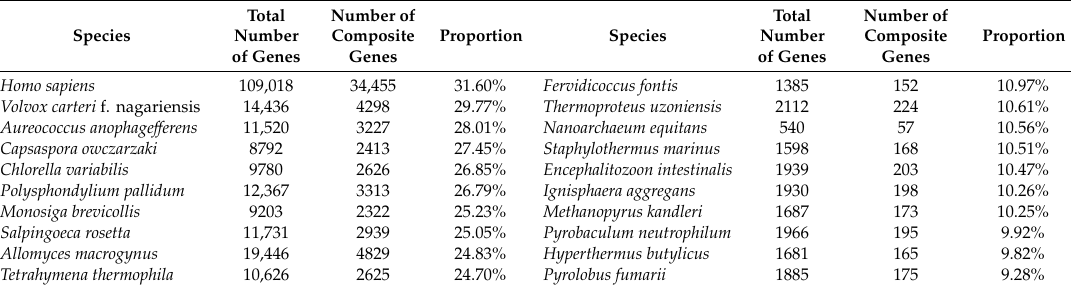
Table 1. The ten species that contain the highest (left) and lowest (right) proportions of composite genes. All species that contains more than 24% composite genes are from eukaryotes, whereas most species that contain less than 11% composite genes are from archaea (Crenarchaeota family, mostly). Number of Number of Total Total Composite Proportion Species Number Composite Proportion Species Number Genes of Genes Genes of Genes Homo sapiens 109,018 34,455 31.60% Fervidicoccus fontis 1385 152 10.97% Volvox carteri f. nagariensis 14,436 4298 29.77% Thermoproteus uzoniensis 2112 224 10.61% Aureococcus anophage ff erens 11,520 3227 28.01% Nanoarchaeum equitans 540 57 10.56% Capsaspora owczarzaki 8792 2413 27.45% Staphylothermus marinus 1598 168 10.51% Chlorella variabilis 9780 2626 26.85% Encephalitozoon intestinalis 1939 203 10.47% Polysphondylium pallidum 12,367 3313 26.79% Ignisphaera aggregans 1930 198 10.26% Monosiga brevicollis 25.23% Methanopyrus kandleri 1687 173 10.25% Salpingoeca rosetta 25.05% Pyrobaculum neutrophilum 1966 195 9.92% Allomyces macrogynus 4829 24.83% Hyperthermus butylicus 1681 165 9.82% Tetrahymena thermophila 2625 24.70% Pyrolobus